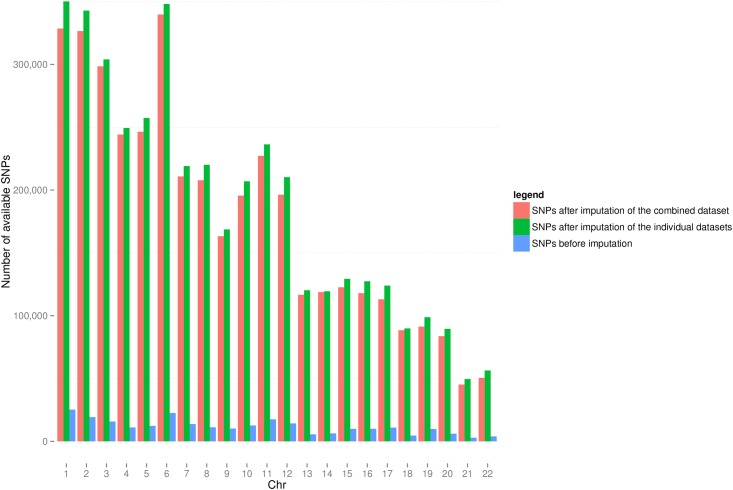
Histogram of number of snps available after both imputation methods.